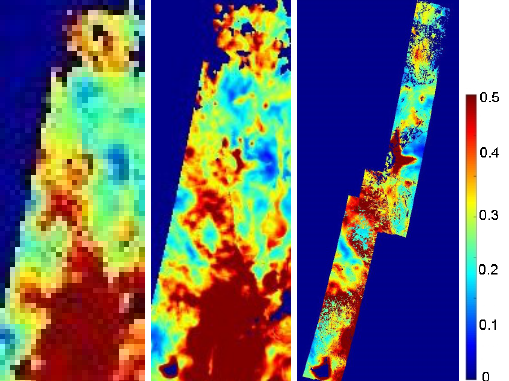
Figure 5. Soil moisture images in cm 3 cm − 3 from central South America at 36 km resolution ( left ), 9 km resolution ( center ), and 3 km resolution ( right ), from day 301 in 2016. The soil moisture is extracted from rSIR-enhanced brightness temperature images. The reduced coverage in the 3 km image is a result of the limited ancillary data availability in the SMAP-Sentinel 3 km soil moisture data